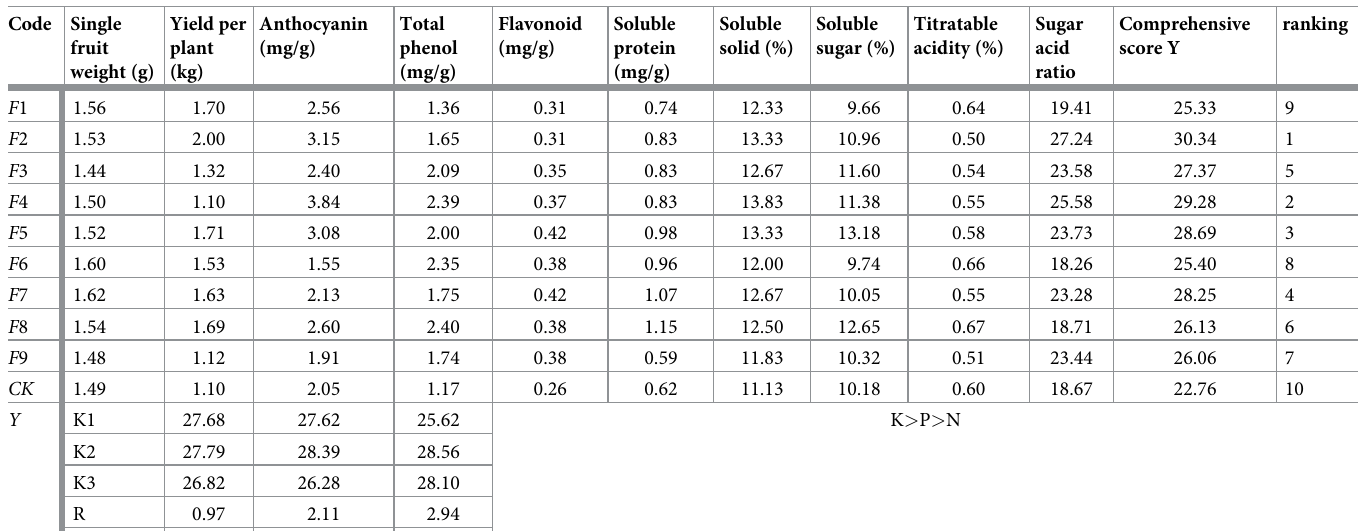
Table 7. Comprehensive evaluation of the effects of nitrogen, phosphorus and potassium fertilization on the yield and quality of blueberry fruit(2016). Code Single Yield per fruit weight (g)